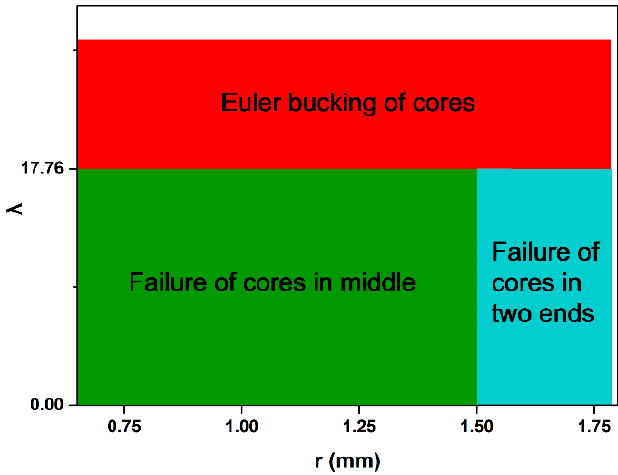
Figure 6. Failure mode maps of the 2-D lattice structures with variable cross-section cores.